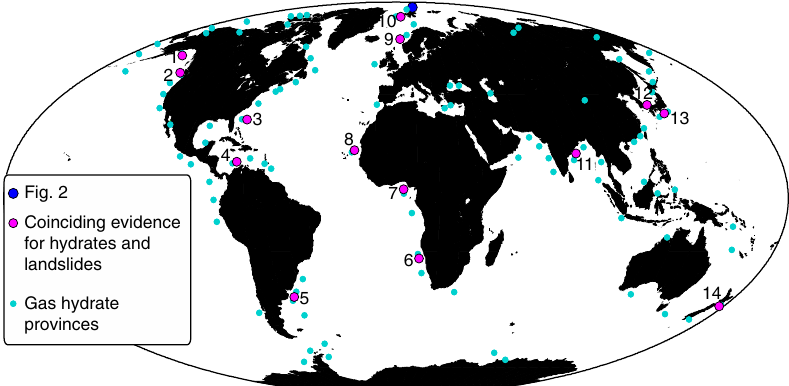
Fig. 1 Global compilation of large submarine landslides in areas with gas hydrates. A global distribution of gas hydrate provinces (turquoise points 3,13 ), coinciding evidence for hydrates and landslides (magenta dots) and the location of Fig. 2 (information on the references for the magenta data points in Supplementary Note